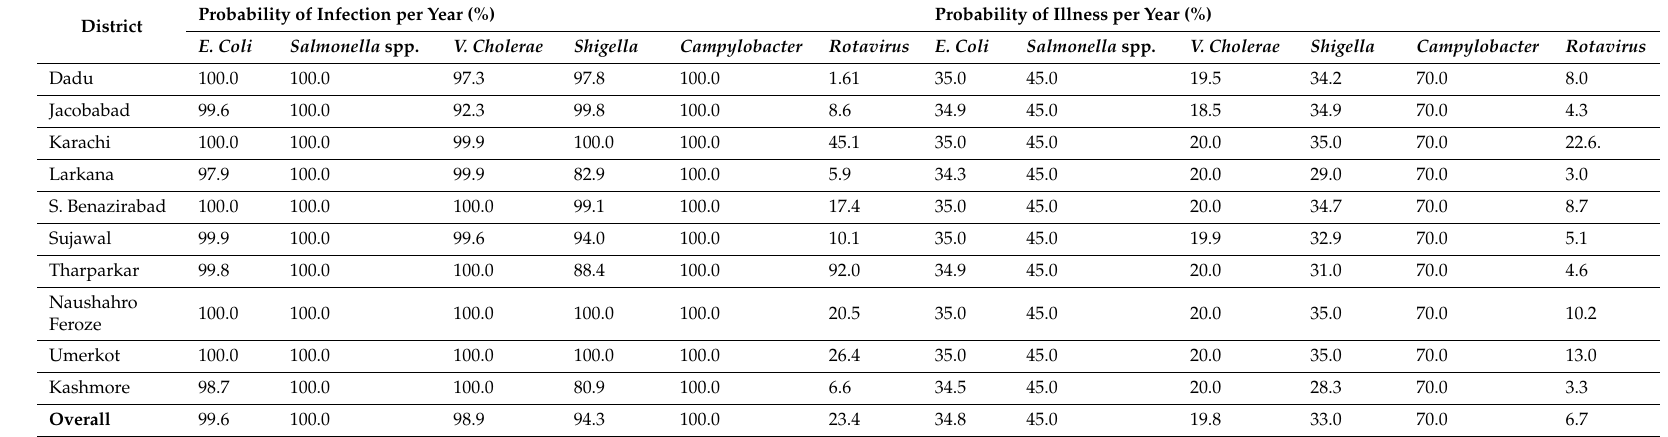
Table 5. Probability of infection per year and probability of illness per year among schoolchildren, due to school drinking-water exposure. Probability of Infection per Year District